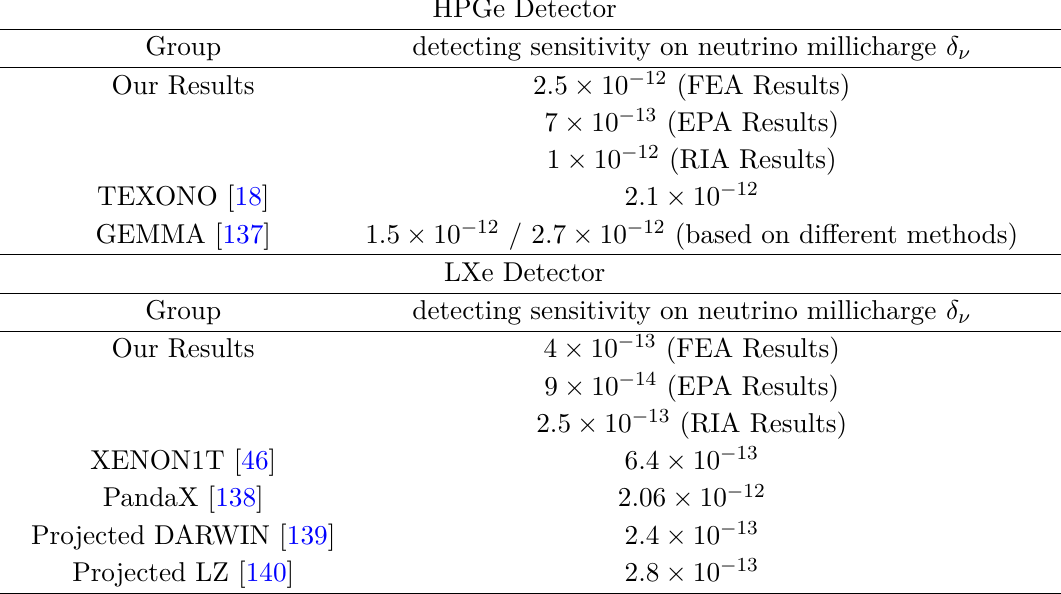
Table 2 . Detecting sensitivity on neutrino millicharge δ ν in the next-generation direct detection experiments. The results for HPGe and LXe based experiments in the FEA, EPA and RIA calcula- tions are given in this table. In the HPGe based next-generation experiments, the energy threshold and background level would be 100 eV and 0.1 cpkkd, respectively. The energy threshold and back- ground level for LXe based next-generation experiments could reach 500 eV and 10 − 4 cpkkd. The current experimental bounds on neutrino millicharge δ obtained from direct detection experiments ν are also given for comparisons. In this table, for the XENON1T, PandaX, projected DARWIN and projected LX experimental bounds, we present the results in reference [21] analyzed using the experimental